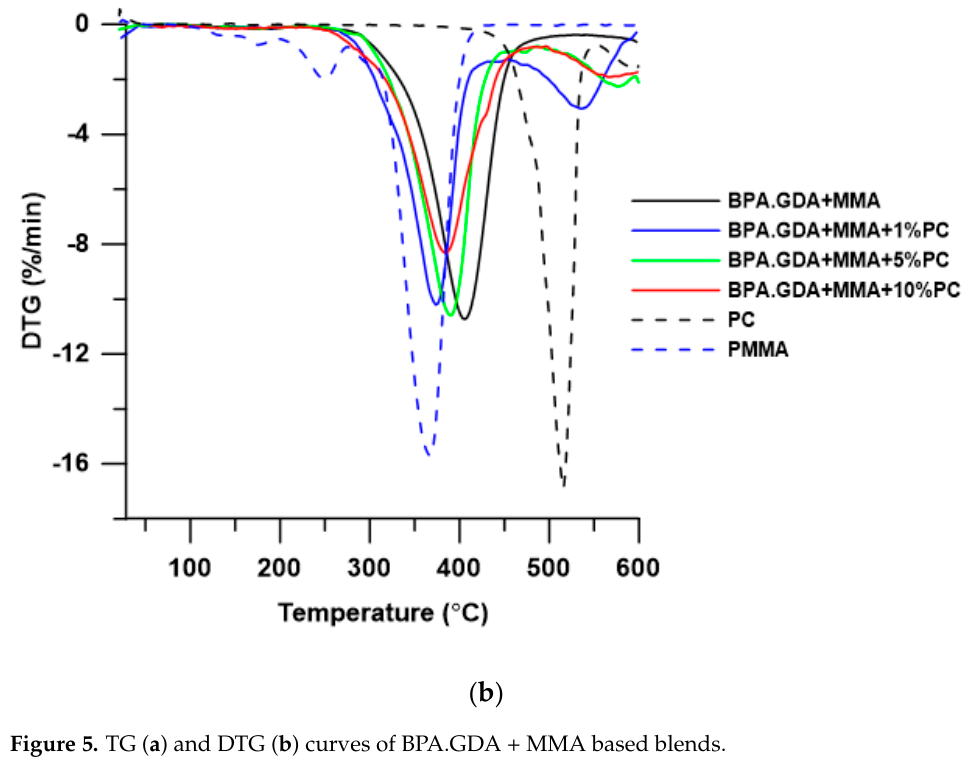
Figure 5. TG ( a ) and DTG ( b ) curves of BPA.GDA + MMA based blends.